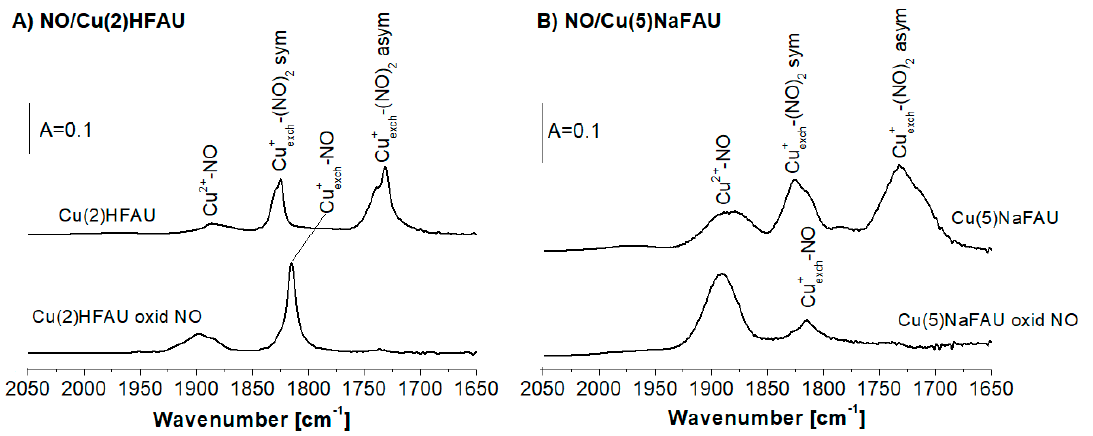
Figure 6. The IR spectra of NO sorbed at 190 K on the Cu(2)HFAU ( A ) and Cu(5)NaFAU zeolites ( B ). All IR spectra were recorded at 190 K and upon heating to room temperature (contact time was 27 h).